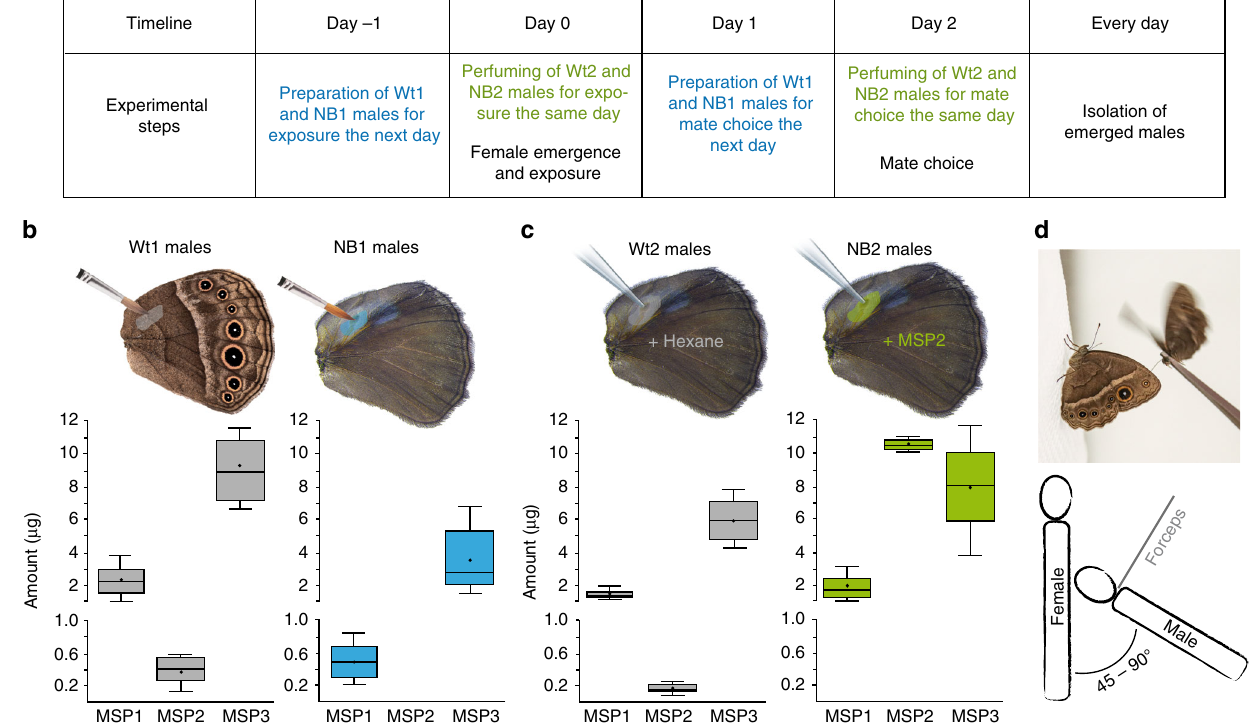
Fig. 1 Experimental procedure. a The timeline of the experiment indicating when each step was performed. b Coating of the male hindwing androconia (NB1 males) prevented the release of MSP2 and reduced the total amount of MSP1 and MSP3 per male (experiment 1). c The average total amount of MSP2 per NB2 male, 30 min after perfuming with synthetic hexadecanal, is increased compared to Wt2 males (experiment 2). In each graph, the horizontal line and the point in each box are the median and the mean amount, respectively. The 25th and 75th percentiles are contained within the outline of the boxes, and the horizontal lines above and below each box show the 1.5 times inter-quartile range of the data. Sample sizes were: n = 5 Wt1 males, n = 7 NB1 males, n = 5 Wt2 males, and n = 10 NB2 males, all independent replicates. d Schematics of the female exposure where the bottom panel illustrates the position of both male and female individuals from a top view. Source data are provided as a Source Data fi